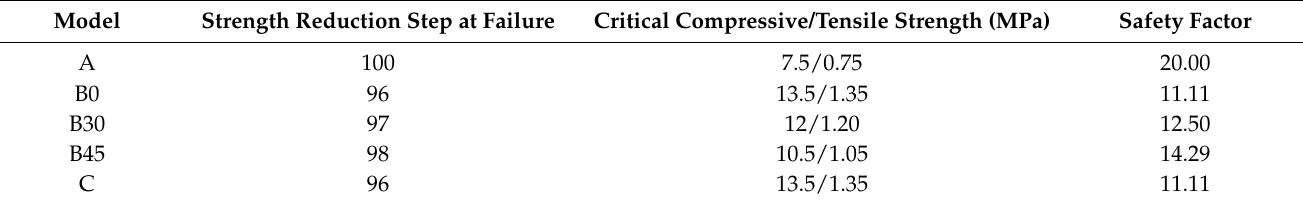
Table 3. The safety factor of the circular tunnels with different surrounding rock